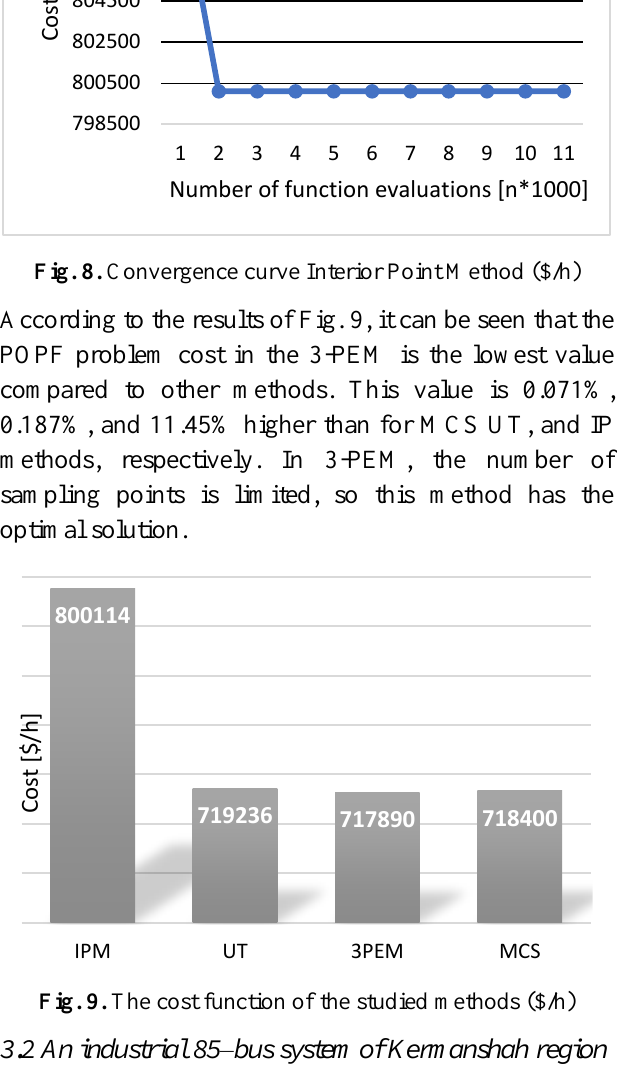
Fig.11. Wind speed curve and probability distribution function of Weibull The curve of average seasonal load consumption profile of the distribution network during the mentioned period is shown in